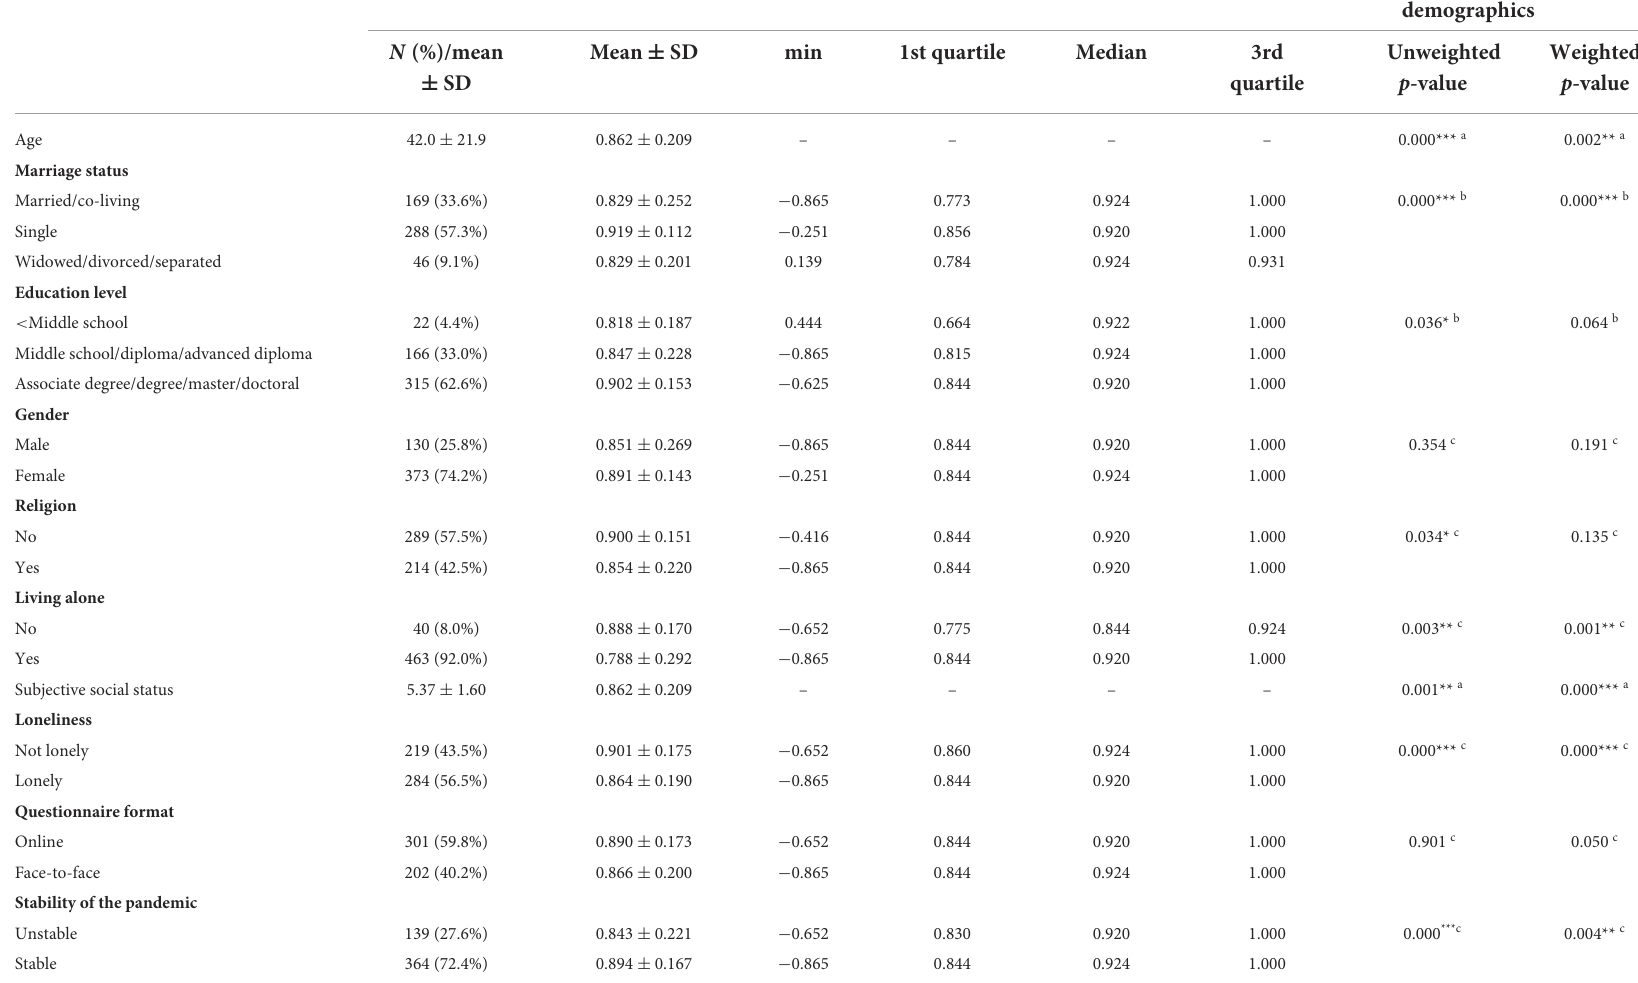
TABLE 1 Sample characteristics and EQ-5D-5L HK index score ( N =